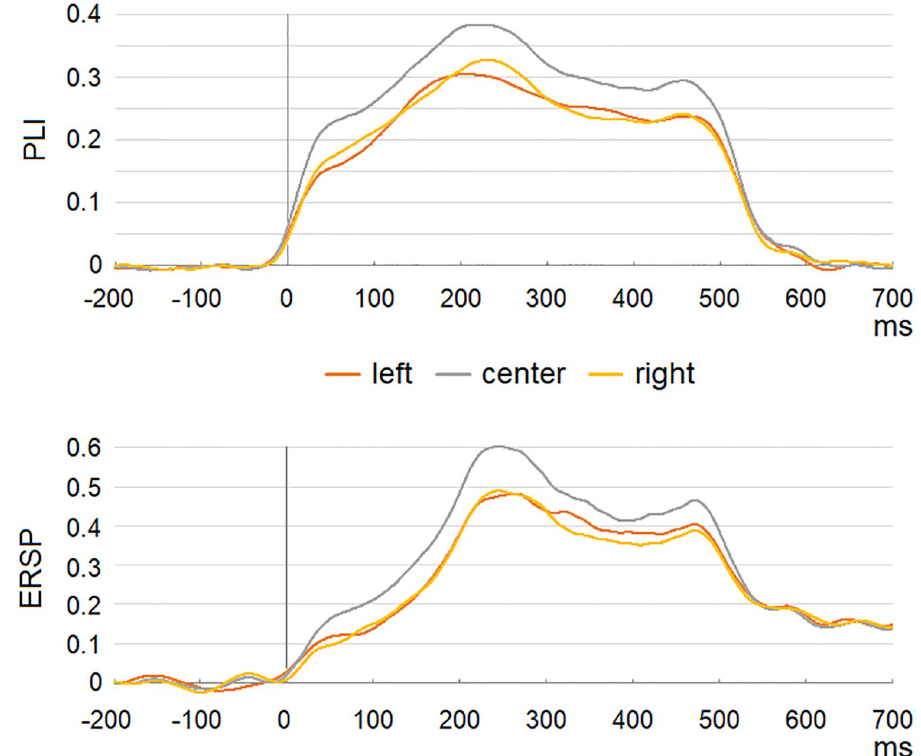
Fig 2. Time course of PLIs (upper panel) and ERSPs (lower panel) for the left, central and right regions in response to 40-Hz stimulation.